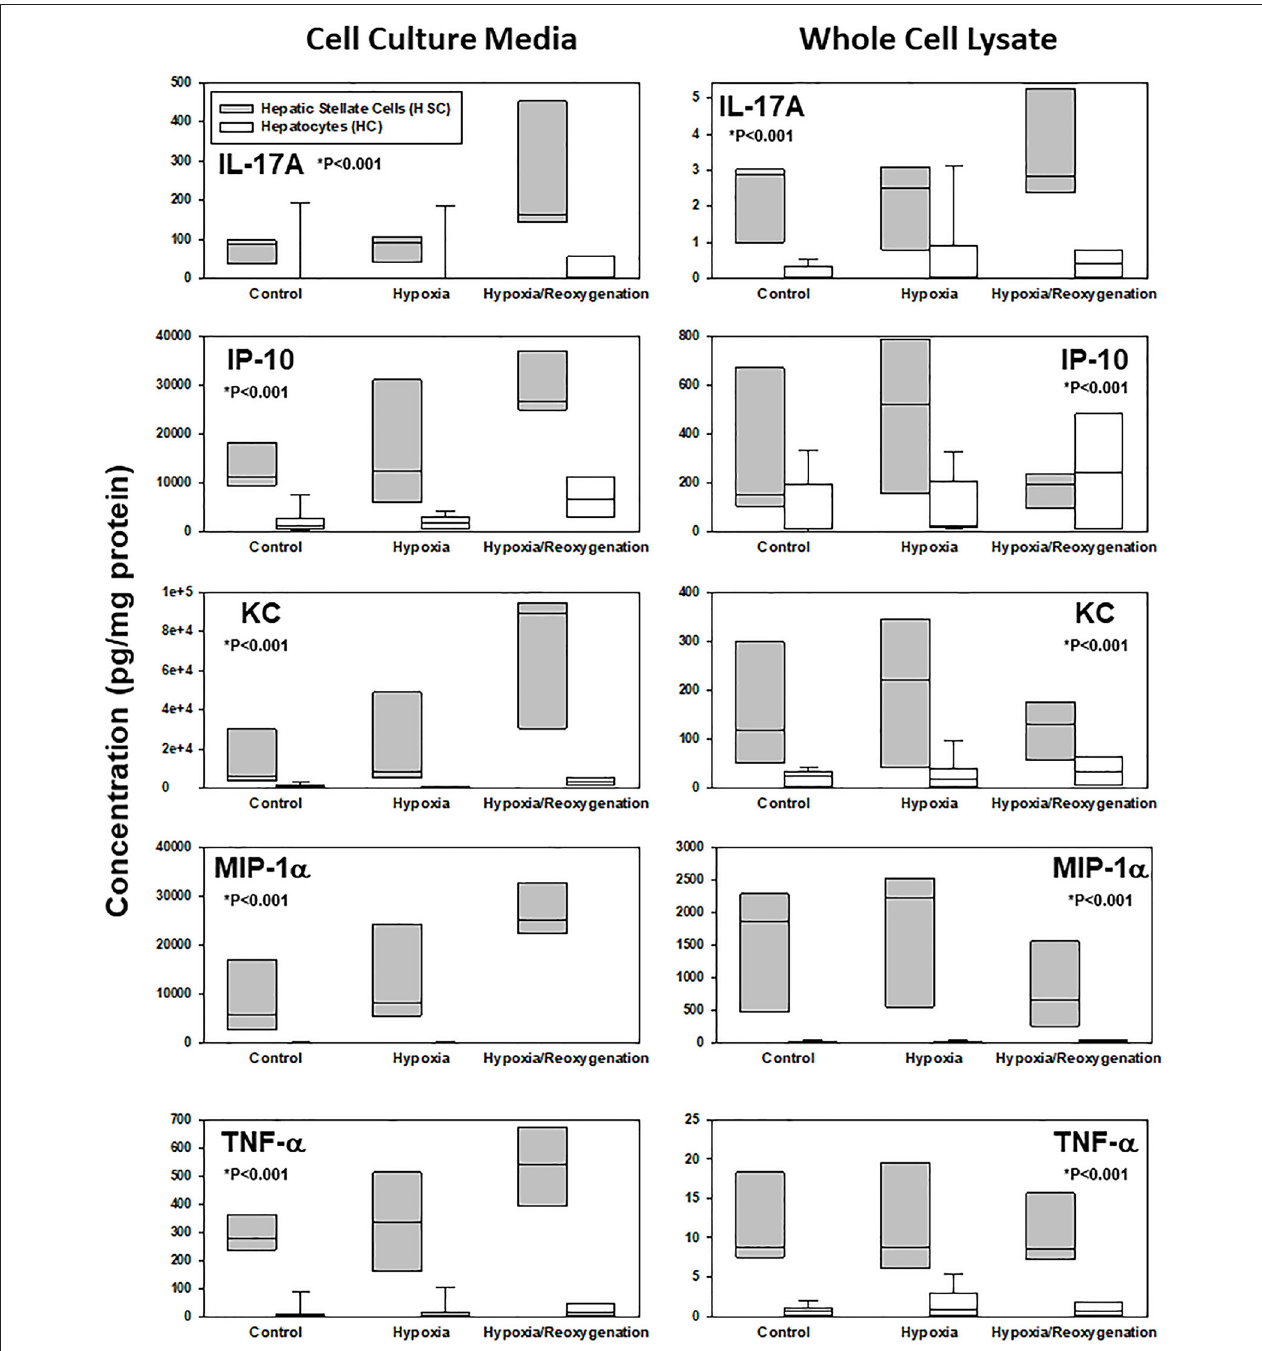
FIGURE 2 | Differential response to hypoxia and hypoxia/reoxygenation in primary mouse hepatic stellate cells (HSC) and hepatocytes (HC). Freshly isolated HSC and HC from C57BL/6 mice were cultured under 21% O 2 for 6h (control), hypoxia (1% O 2 ) for 6h or hypoxia (6h) followed by reoxygenation for 18h. Inflammatory mediators were measured by Luminex TM in both cell culture media and whole cell lysate as described in Materials and Methods. Box plots show the levels of IL-17A, IP-10, KC, MIP-1 α , and TNF- α , where the line within the box marks the median and the lower and upper boundaries represent the 25th and 75th percentiles, respectively (* P < 0.001, HSC vs. HC, analyzed by Two-Way ANOVA).